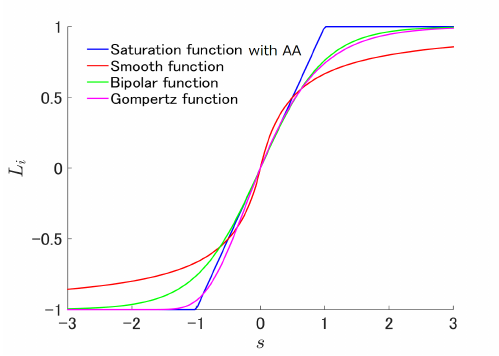
Figure 6. Candidate